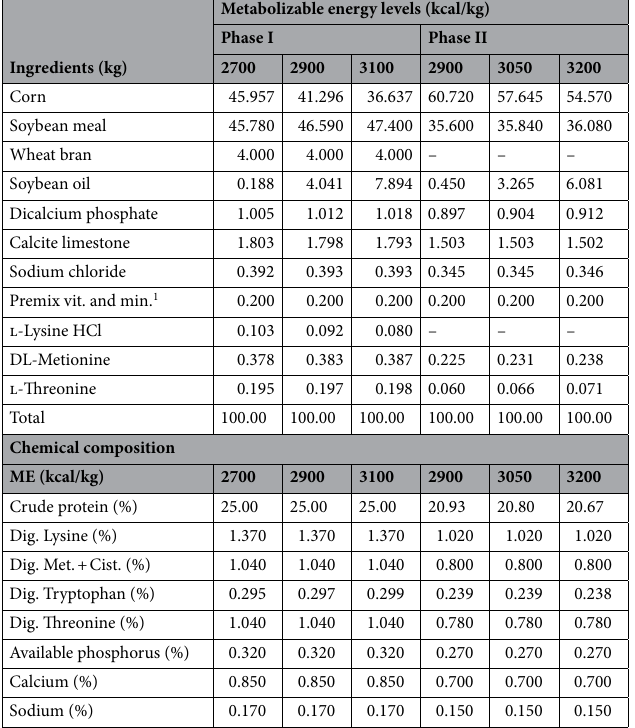
to determine the area, width and depth of the M. pectoralis major as a function of quail age and metabolizable energy levels in the diets. Relative weight of viscera and body chemical composition. After ultrasound, the quails (n = 15 birds from each treatment) were submitted to a six-hour fasted and were euthanized by cervical dislocation 28 . The quails were plucked, opened by the back, eviscerated, followed by carcass hygiene and weighed. Then, the heart, liver, pancreas, proventriculus, gizzard, intestine (both small and large intestine) and abdominal fat were removed and weighed to calculate their relative weight 29 . Carcasses and organs were frozen and stored for further analysis of body composition. For body chemical composition, the whole carcasses with feathers and organs were placed in an autoclave, then ground, weighed, homogenized and taken to a forced ventilation oven at 55 °C for 72 h. The proximal